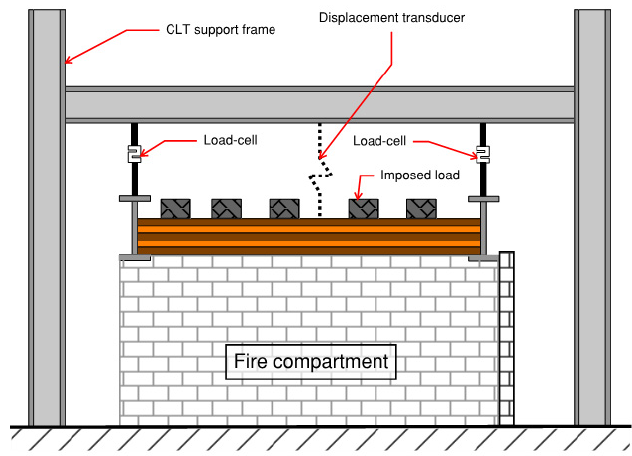
Figure 7. Illustrative section through the rig showing CLT support mechanism, including load cells and displacement transducers.